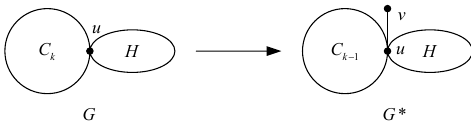
Figure 3. The graphs G and G ∗ in Transformation